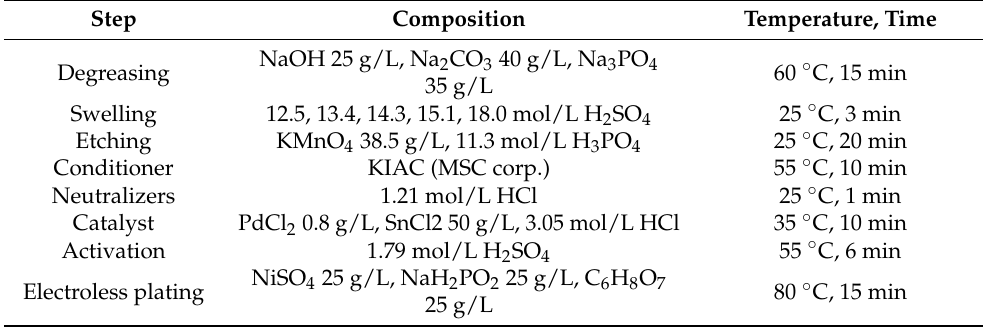
Table 1. The composition of the solutions used in each step for electroless nickel